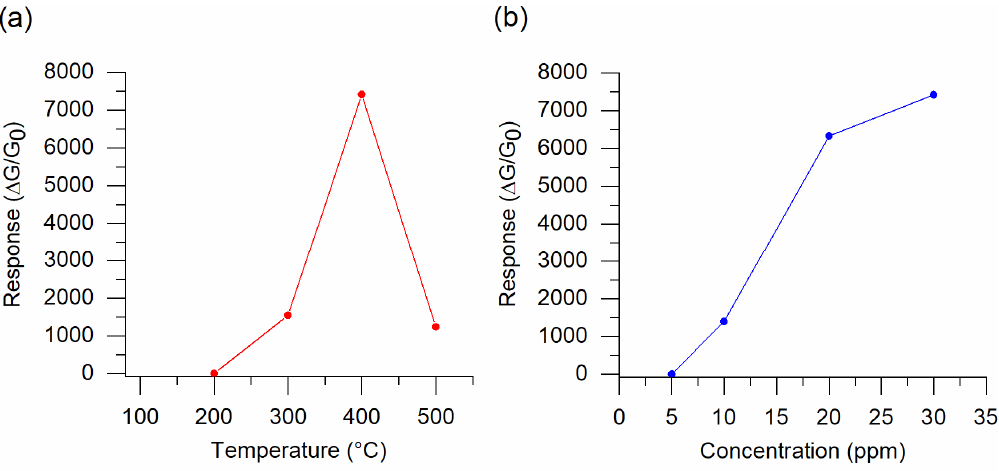
Figure 2. ( a ) Gas sensing response versus operating temperature dependence of the ZnO nanomaterial towards 30 ppm of H 2 S. ( b ) Gas sensing response variation of the ZnO nanomaterial depending on the concentration of H 2 S (5, 10, 20 and 30 ppm) at 400 °C.